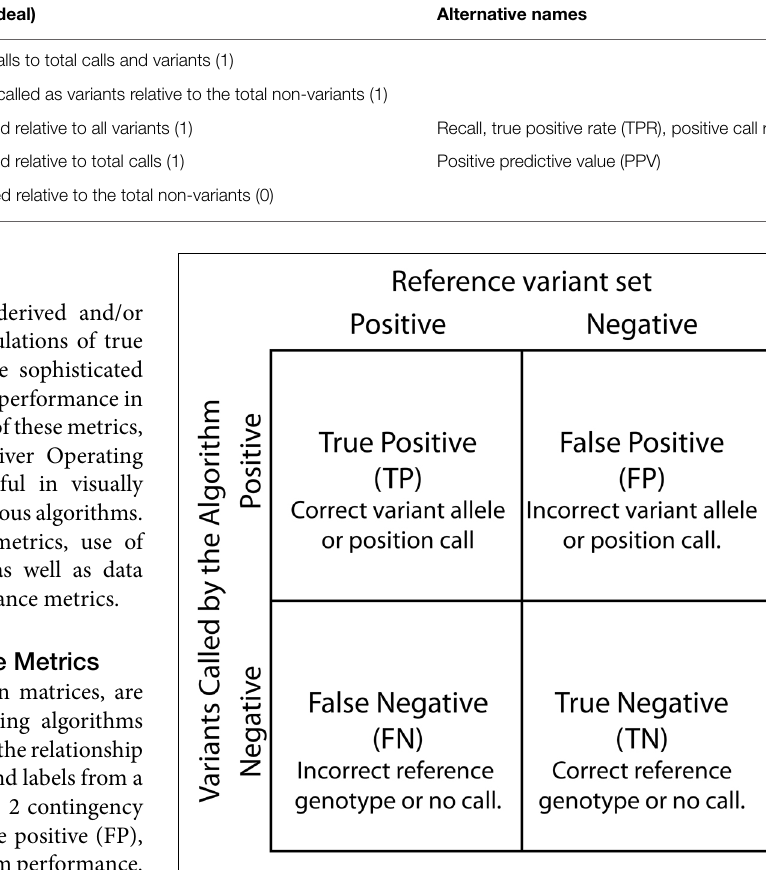
FIGURE 3 | Contingency table. True Positive, False Positive, False Negative, and True Negatives are defined based by the relationship between variants called by the SNP calling algorithm and known differences between the reference genome and the analyzed